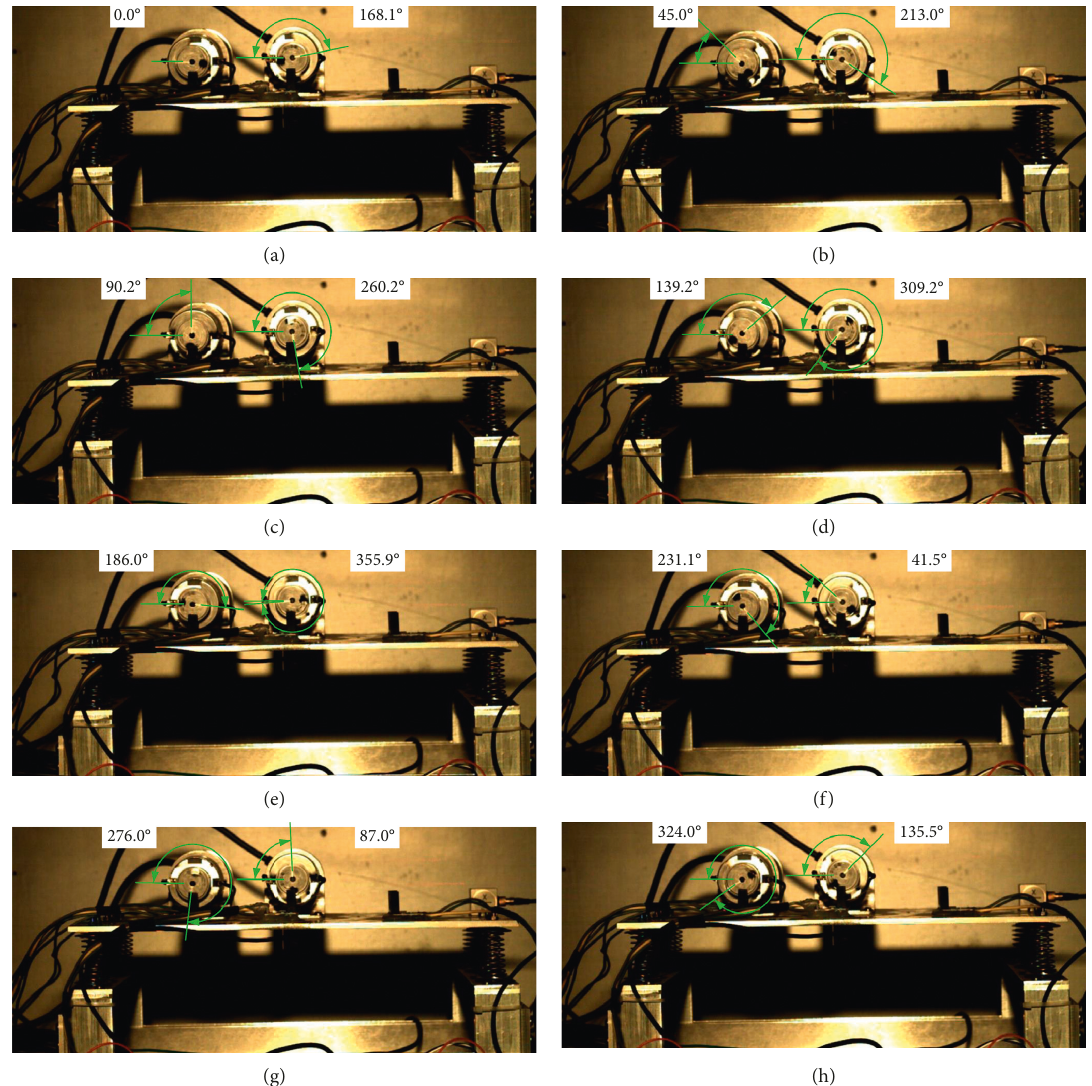
Figure 8: The phase difference of vibration synchronization of two ERs with the clockwise rotational direction. (a) φ